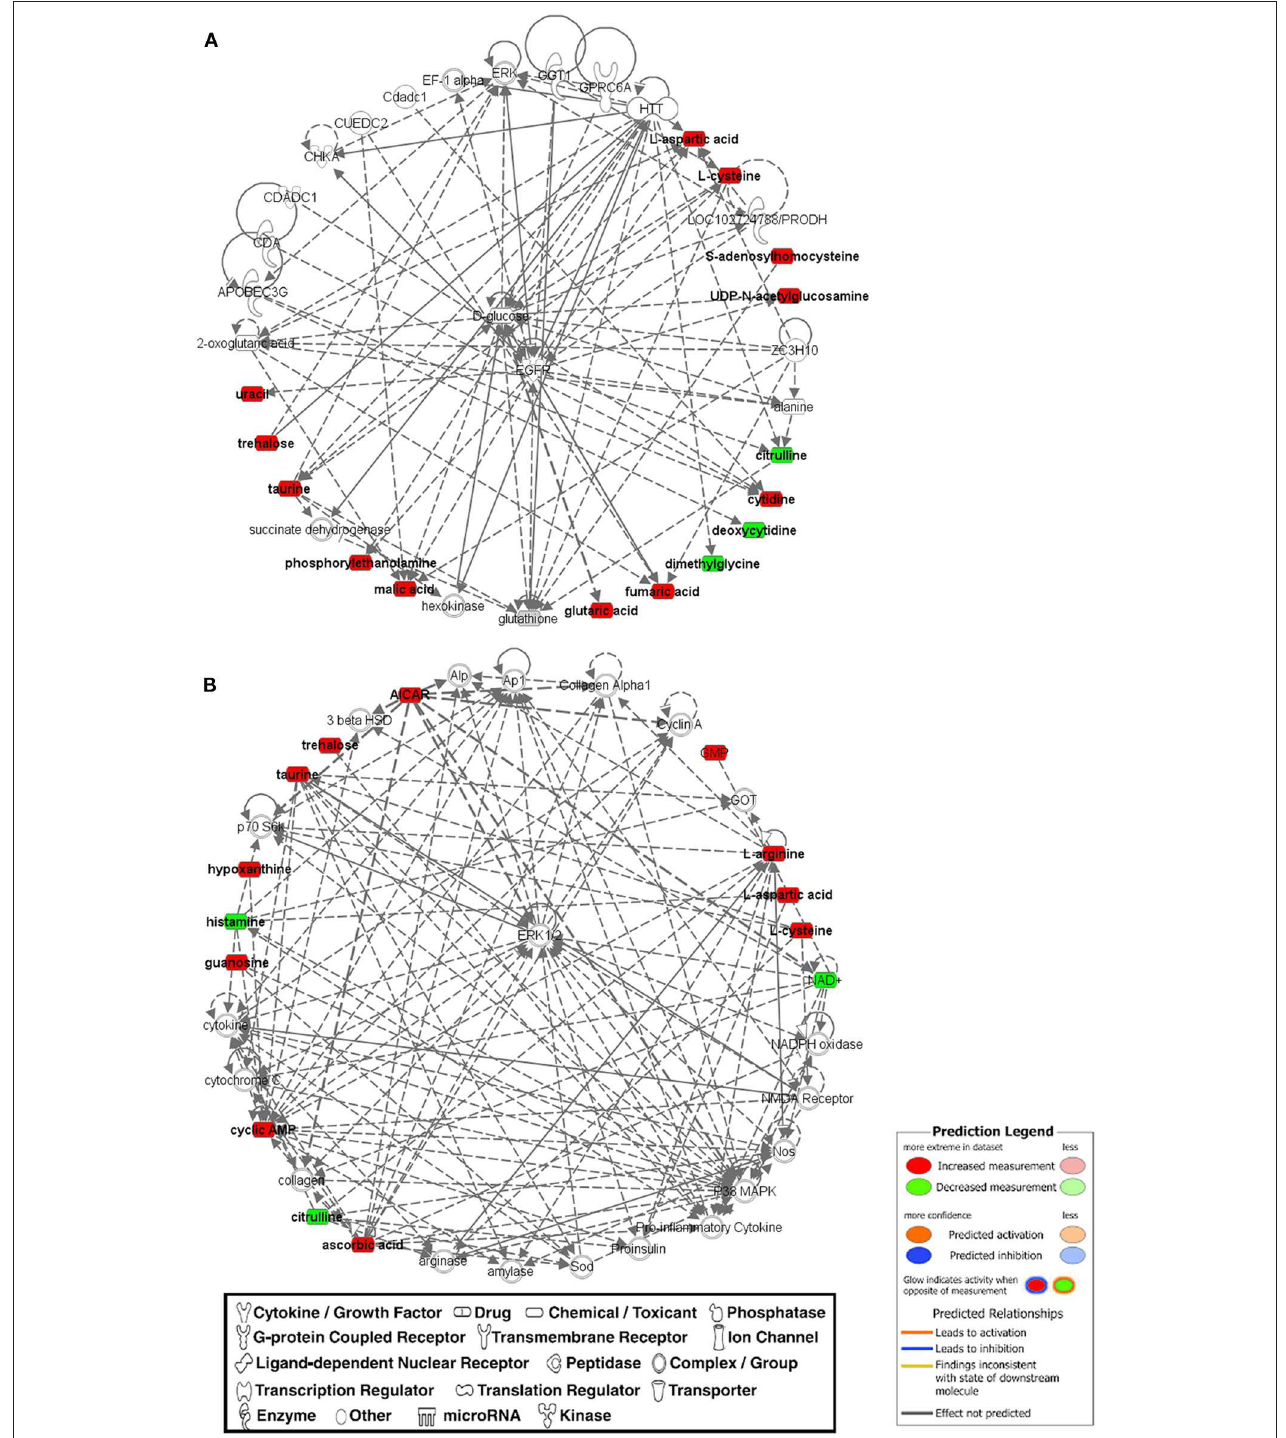
FIGURE 3 | The top two networks (A,B) built with IPA program from metabolomics data that was determined on WB-affected muscles. Metabolites in red were upregulated and metabolites in green were down-regulated in WB-affected tissues. Networks constructed from the IPA knowledgebase by connecting the altered molecules are not limited by canonical pathway boundaries. EGFR, epidermal growth factor receptor; ERK, extracellular signal-regulated kinase.